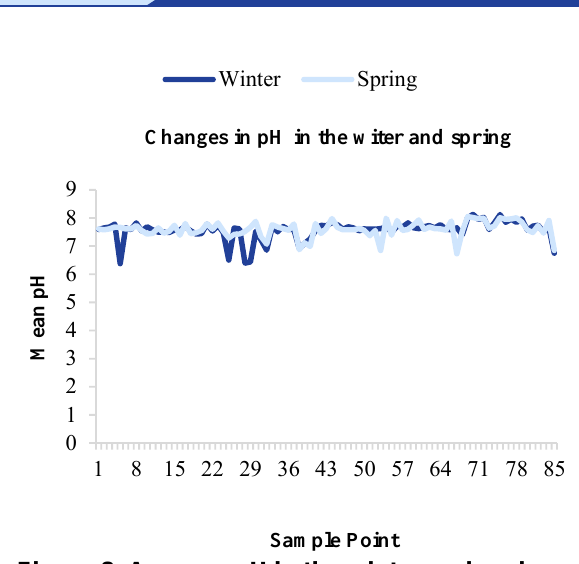
Figure 8. Average pH in the winter and spring